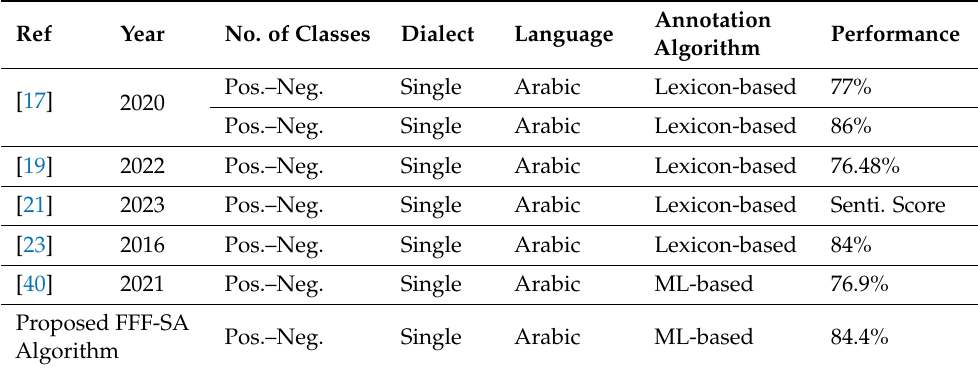
Table 7. Comparison with recent sentiment analysis performance .